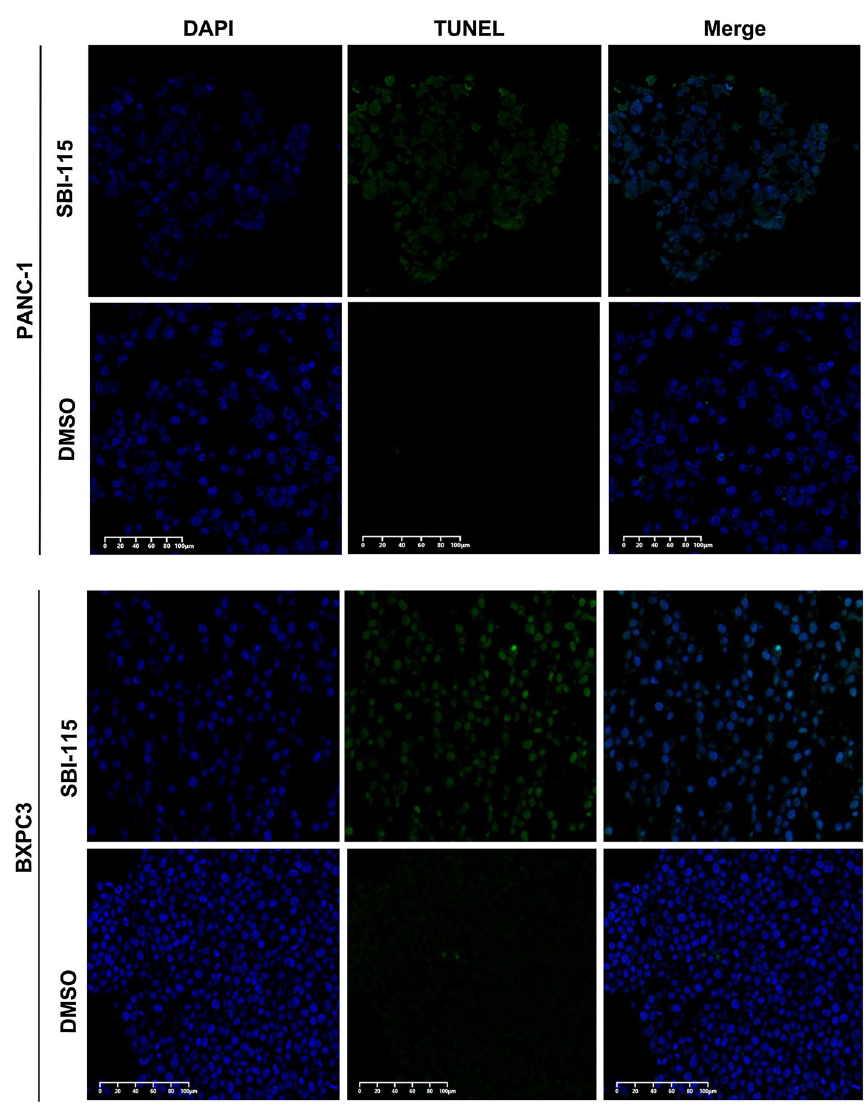
Fig. 3 Antagonizing TGR5 induced pancreatic cancer cell apoptosis in vitro by using TUNEL assay. (green, TUNEL- positive; blue, DAPI). Scale bar:100